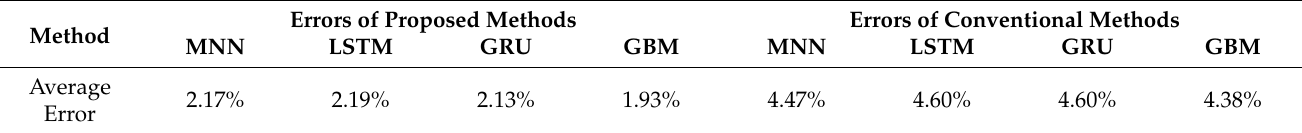
Figure 13. The MAE obtained using the proposed and conventional methods. Table 10. Average battery errors produced using the generated models.